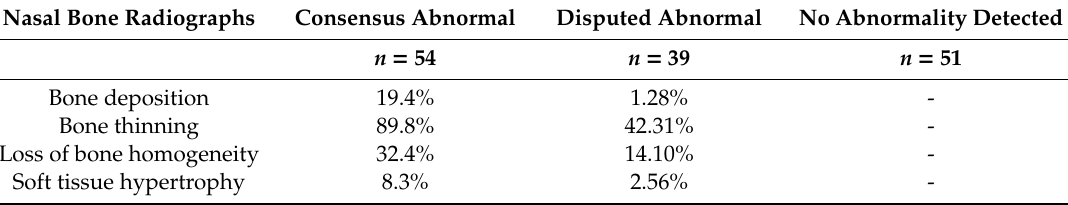
Table 2. The average of the two radiologists’ scores as percentage of the number of horses a ff ected. Types of radiographic lesion noted in those horses with consensus abnormal, disputed abnormal, and consensus normal radiographic films with respect to the nasal bone lesions included in this study. Nasal Bone Radiographs Consensus Abnormal Disputed Abnormal No Abnormality Detected n = 54 n = 39 n = 51 Bone deposition 19.4% 1.28% - Bone thinning 89.8% 42.31% - Loss of bone homogeneity 32.4%